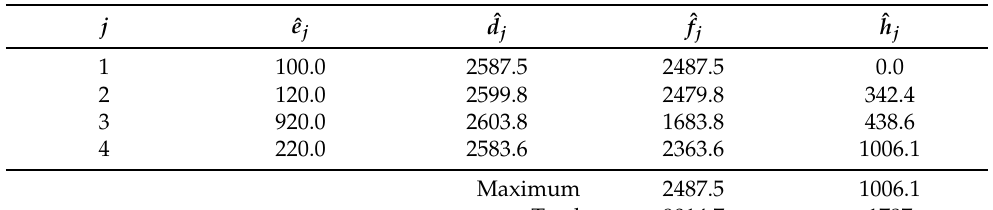
Table 6. Job flowtime and sublot finish-time separation performance measures ( ˆ f mas , ˆ f total , ˆ h mas , and ˆ h total